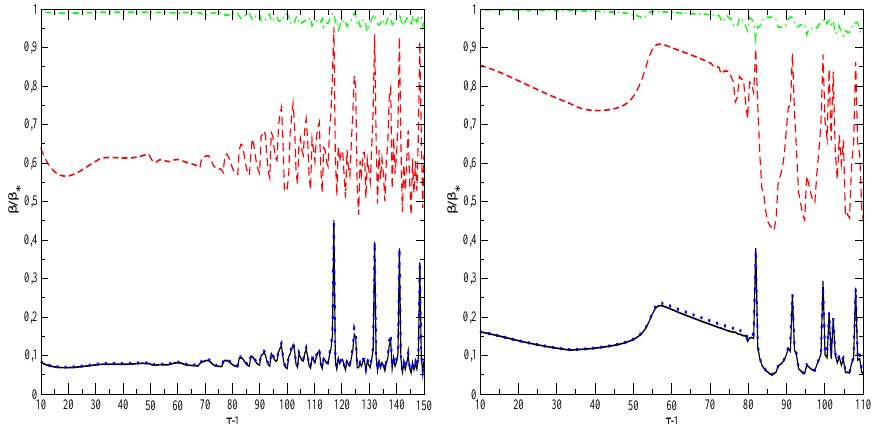
Fig. 2. Left-hand panel . Inclination angle β in the units of the stream inclination, β ∗ , at the stream impact position r = 1 as a function of time τ = t/P min shown for the grid-based model with α = 0 . 3. See the text for a description of different particular curves. Right-hand panel : the same as left-hand panel, but for α = 0 .